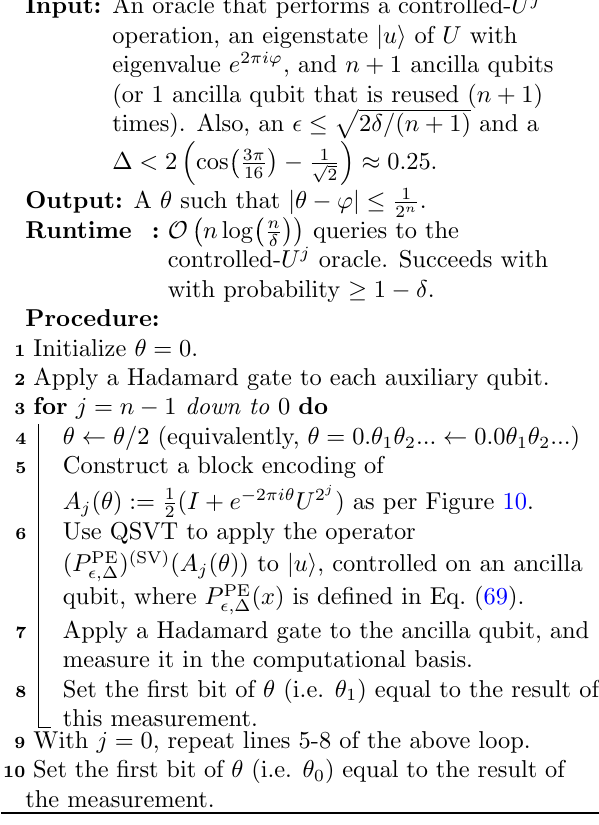
Algorithm 3. Phase Estimation by